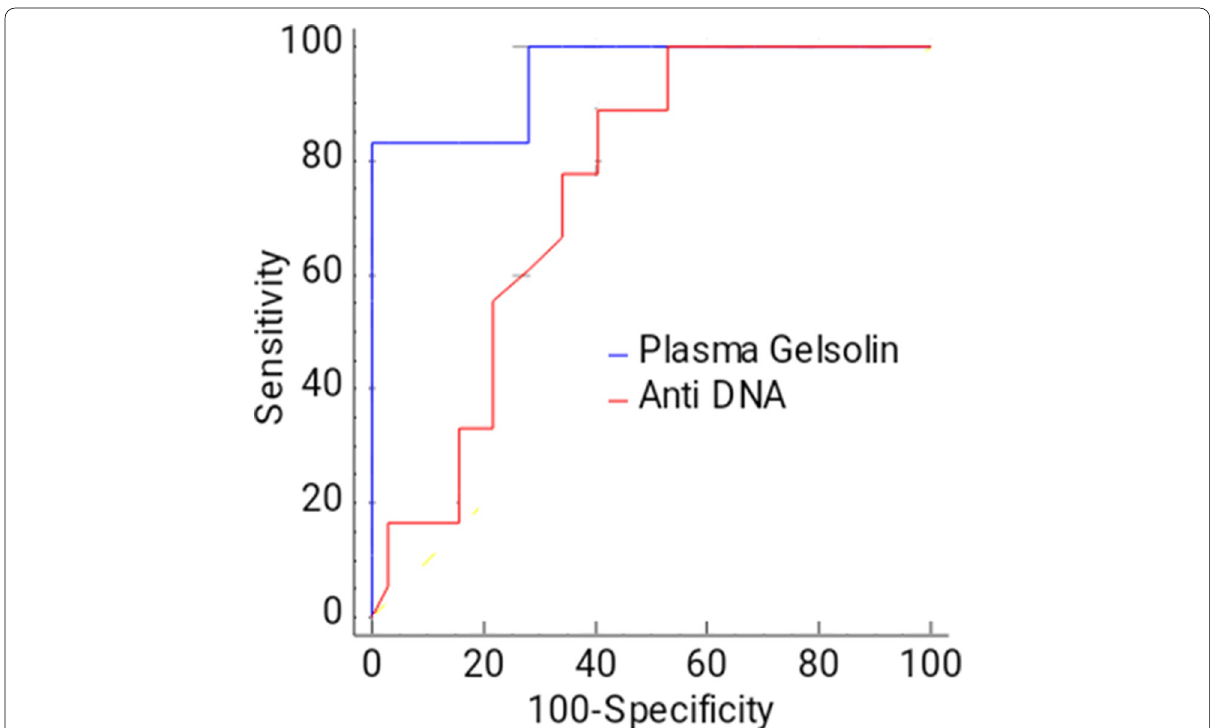
Fig. 3 Receiver operating characteristic (ROC) curves of plasma glesolin level versus anti-double-stranded deoxyribonucleic acid (anti-ds DNA) in the prediction of renal affection in systemic lupus erythematosus (SLE)